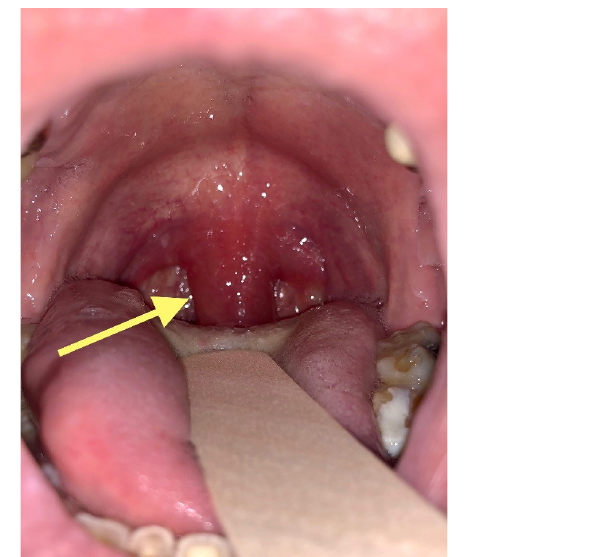
Image. Picture of oropharynx during primary evaluation of patient demonstrating isolated uvular angioedema